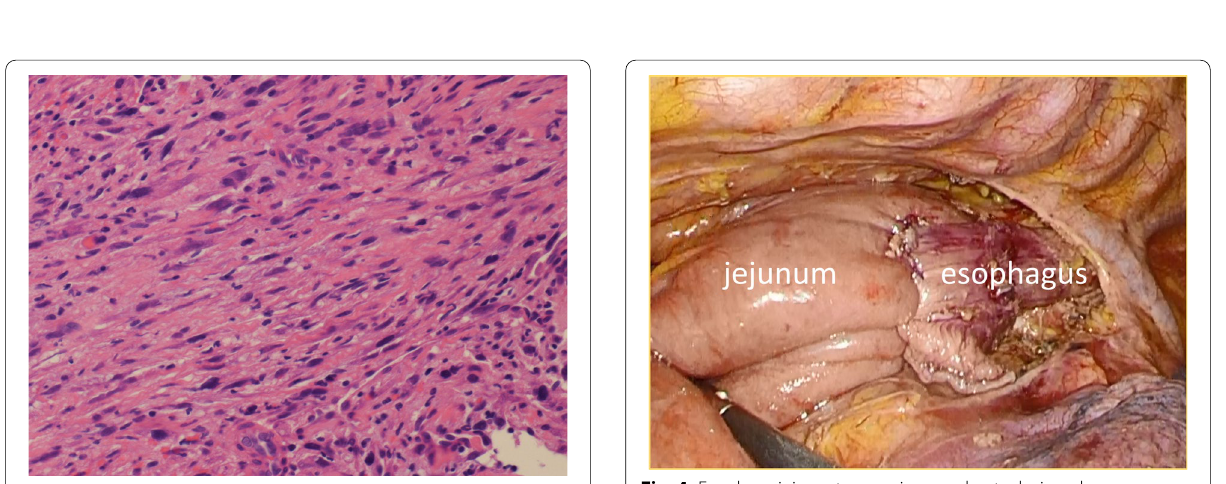
Fig. 3 Microscopic examination of the biopsy specimen showed pleomorphic atypical spindle cells with increased mitotic activities. (hemotoxylin and eosin stain, 200 ) ×